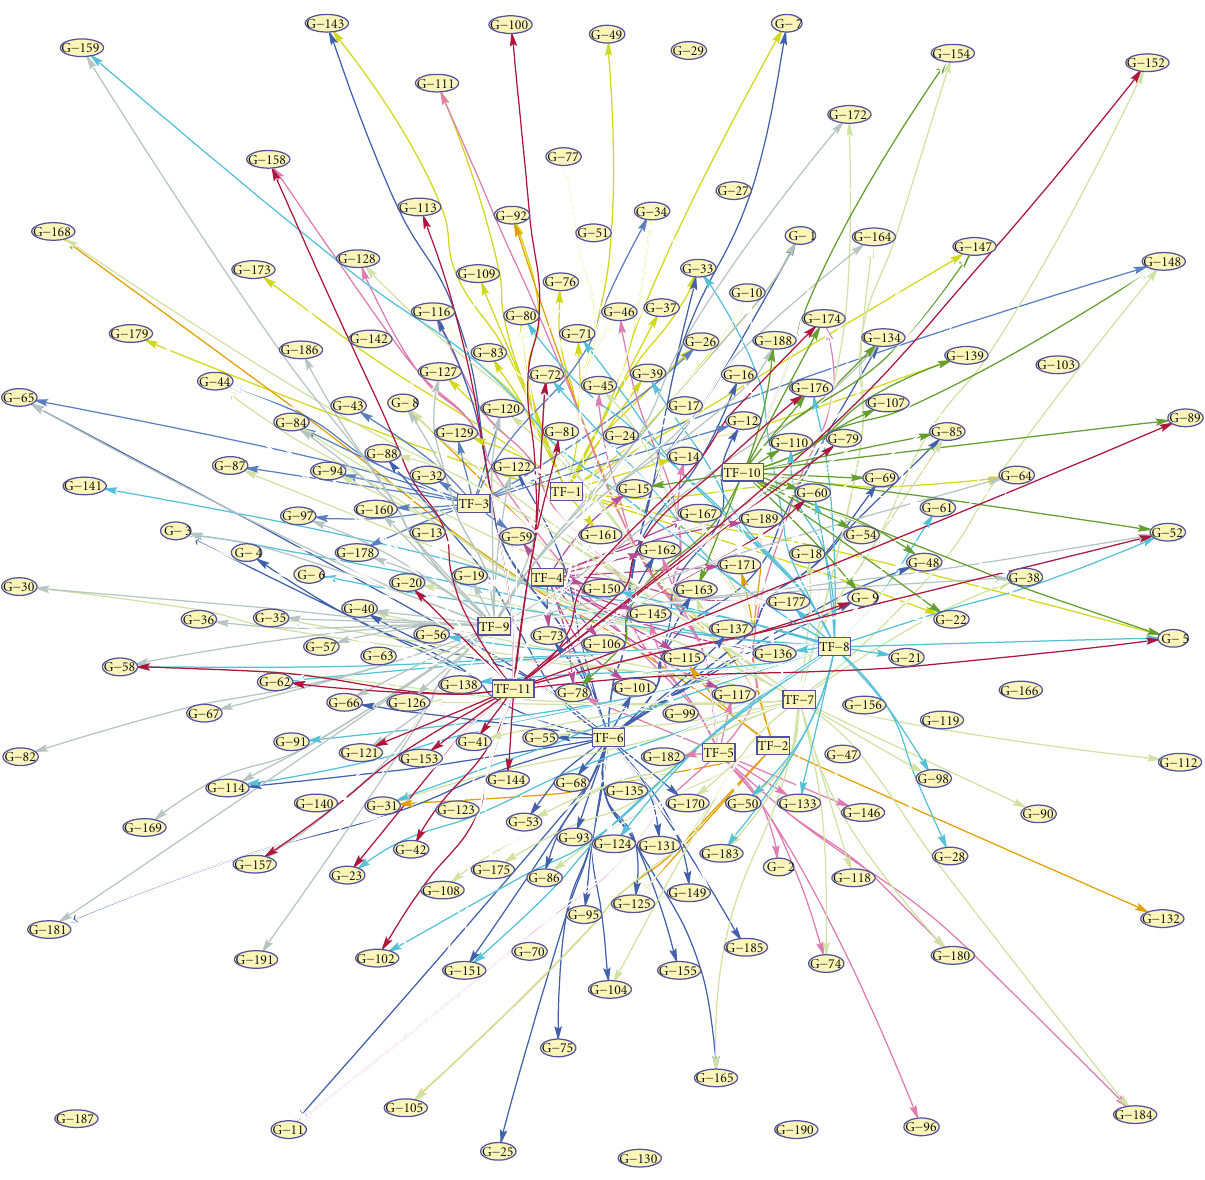
Figure 10: Transcriptional regulatory network in ER +